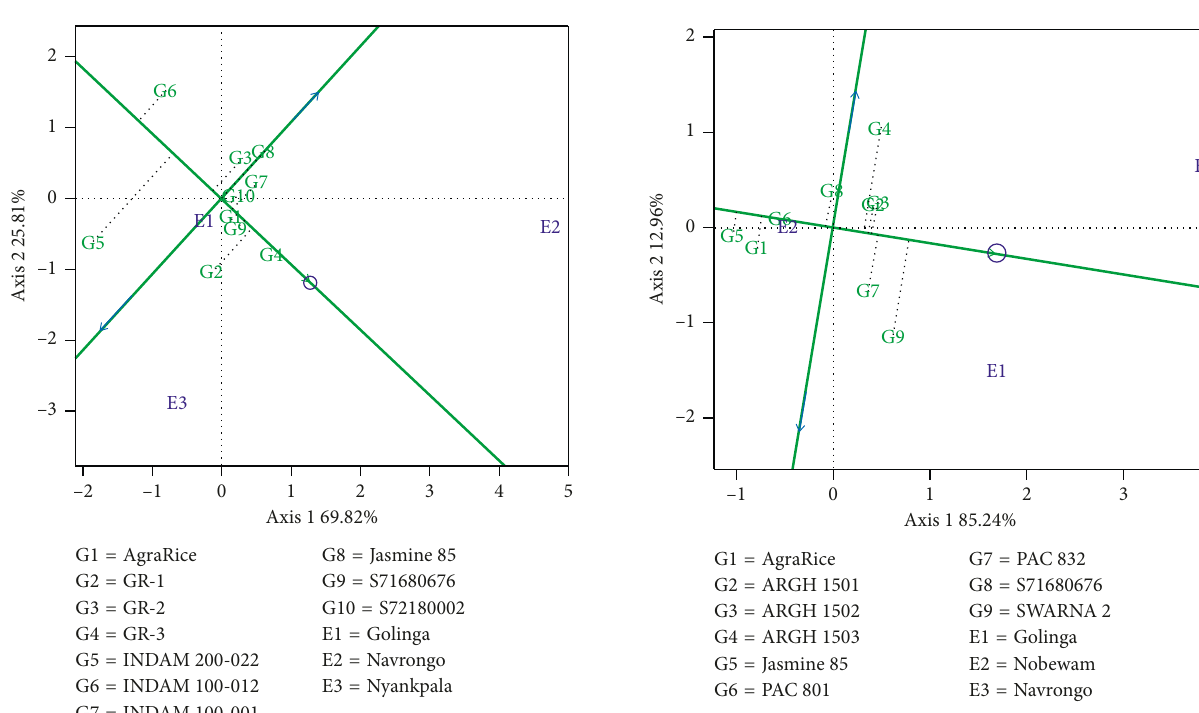
Figure 2: Mean versus stability of grain yield for hybrids and checks in 2015. Figure 1: Mean versus stability of grain yield for hybrids and